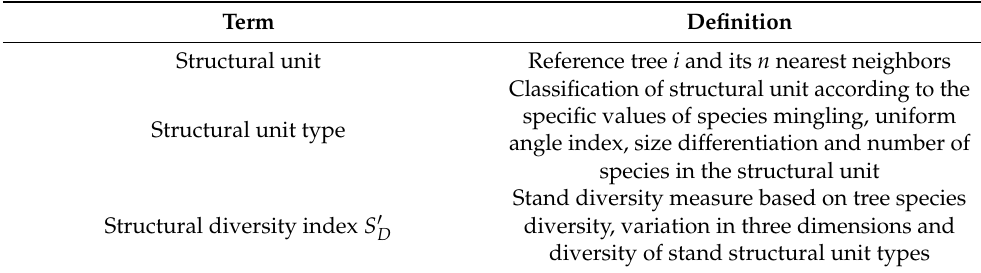
Table 1. Definition of